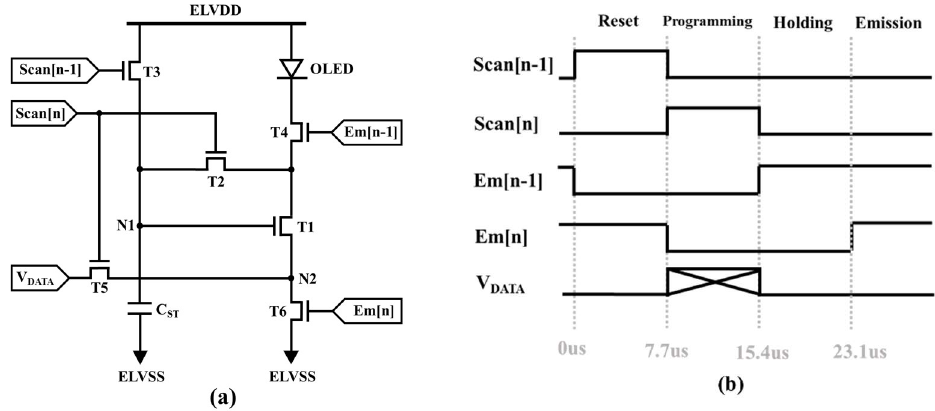
Figure 1. ( a ) The schematic of the proposed 6T1C pixel circuit and ( b ) the timing diagram of the control signals.